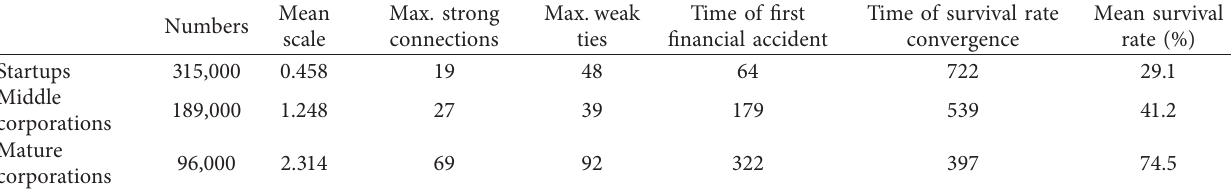
Table 2: General index of startups, middle corporations, and mature